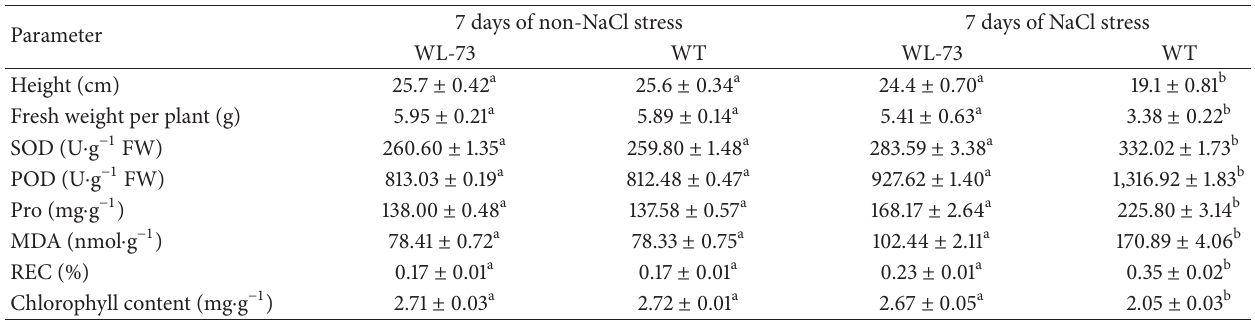
Table 2: Height and fresh weight of maize WL-73 and WT under 300 mM NaCl